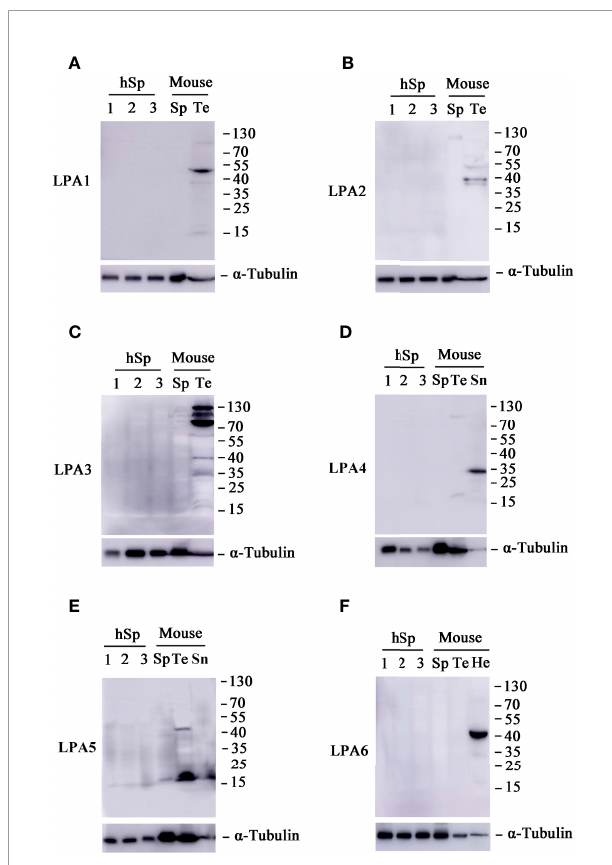
FIGURE 6 | Expression patterns of lysophosphatidic acid (LPA) receptors in sperm. Western blot analyses of proteins LPA1 (A) , LPA2 (B) , LPA3 (C) , LPA4 (D) , LPA5 (E) , and LPA6 (F) in human sperm (hSp), mouse sperm (Sp) and testis tissue (Te). Spleen (Sn) tissues were also included in the experiments for LPA4 and LPA5, whereas heart (He) tissues for LPA6. The blot was probed with monoclonal antibodies against a -tubulin to assess protein